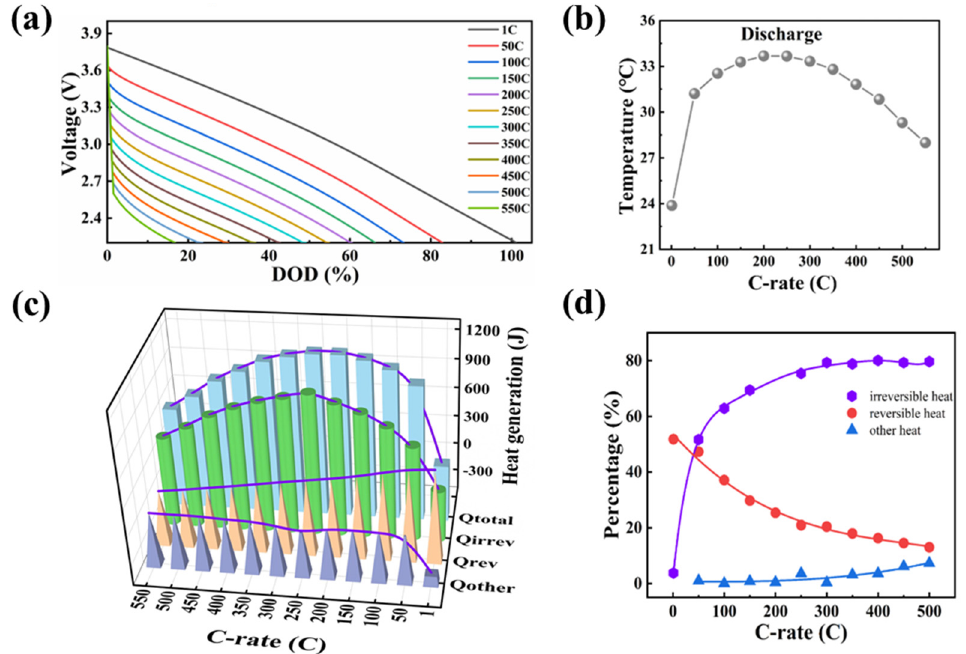
Figure 8. ( a ) Discharge voltage curves of LIC cells at different rates, ( b ) maximum temperature at the end of discharge as a function of C-rate, ( c ) heat generation of pouch cells at diverse discharge rates, and ( d ) the percentage contribution of each type of heat in the cell heat distribution, reproduced with permission from [112]. Copyright 2022, Elsevier.